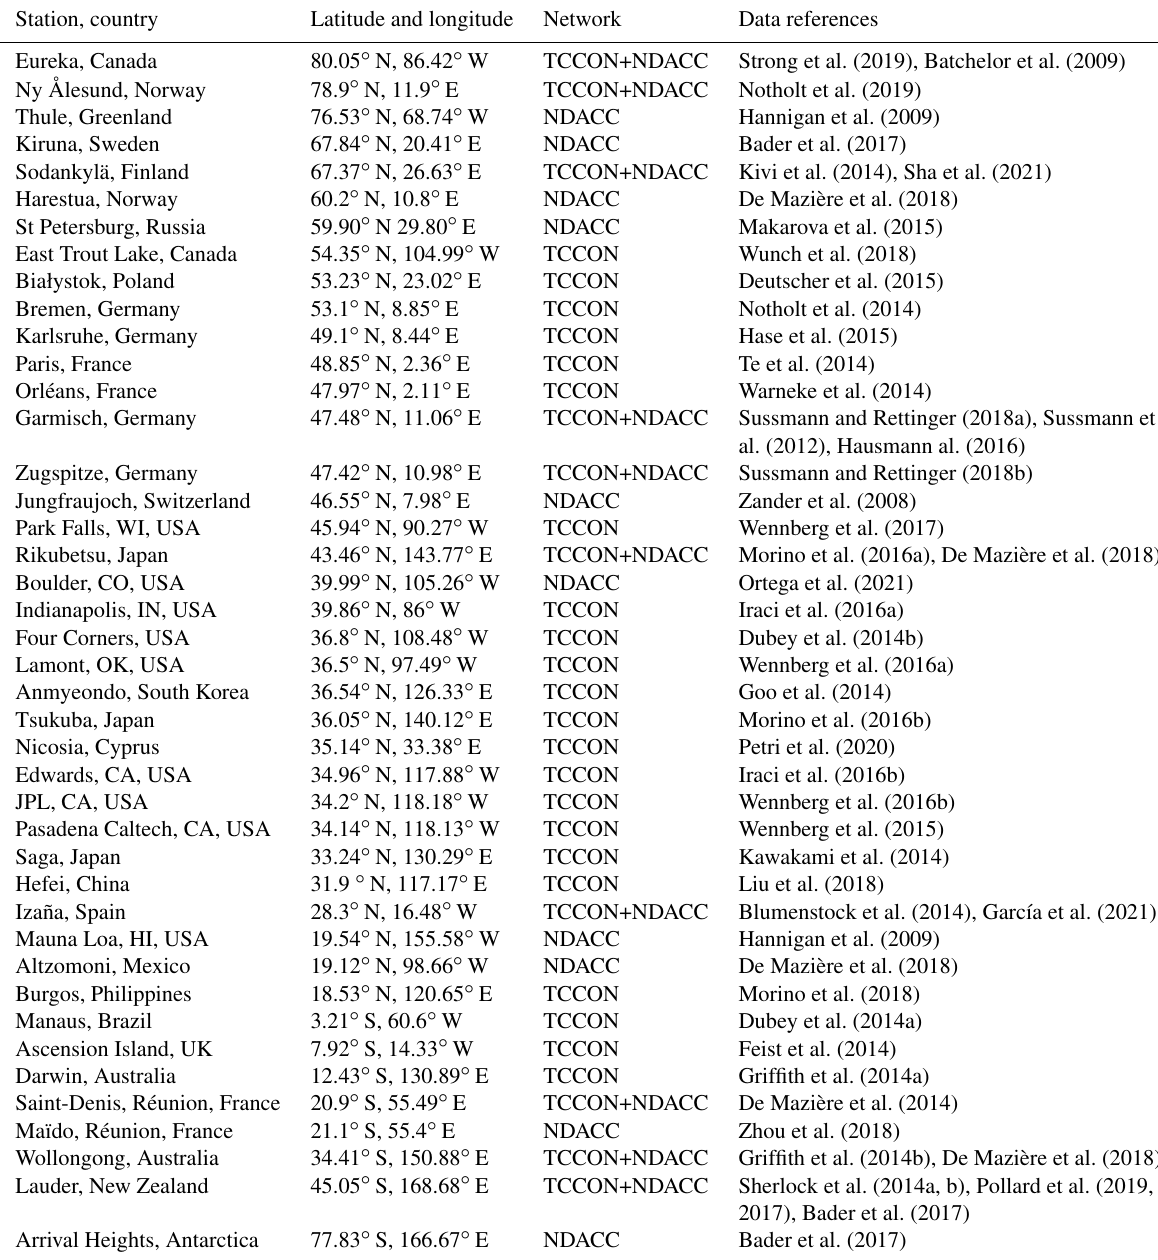
Table A2. List of total column stations used for the evaluation in Sect. 3.1. Station,